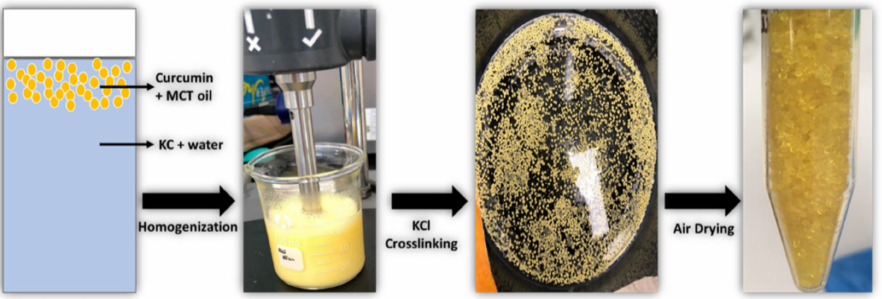
Figure A1. The preparation of CUR loaded-MCT encapsulated-KC beads.